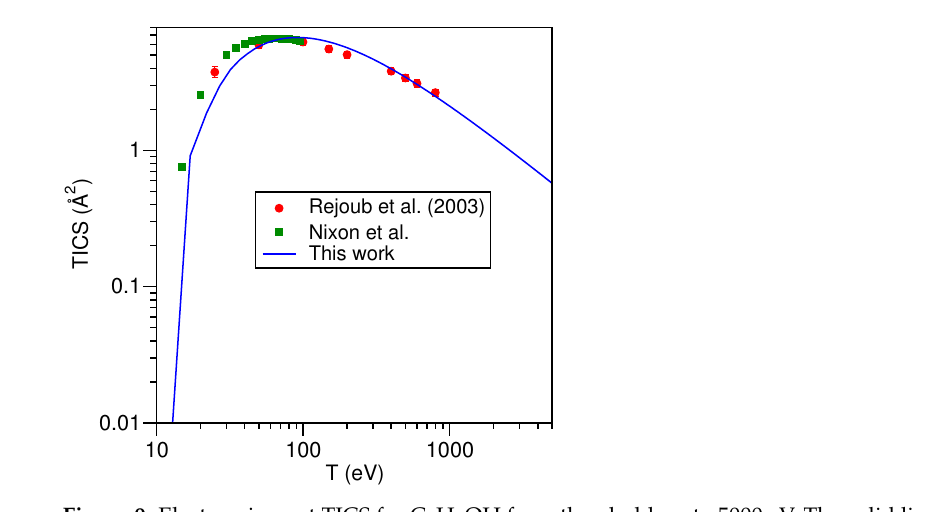
Figure 9. Electron-impact TICS for C 2 H 5 OH from threshold up to 5000 eV. The solid lines represent the TICS computed by numerically integrating the SDCS values. The filled circles and squares represent the experimental measurements of Nixon et al. and Rejoub et al., respectively [54,55].